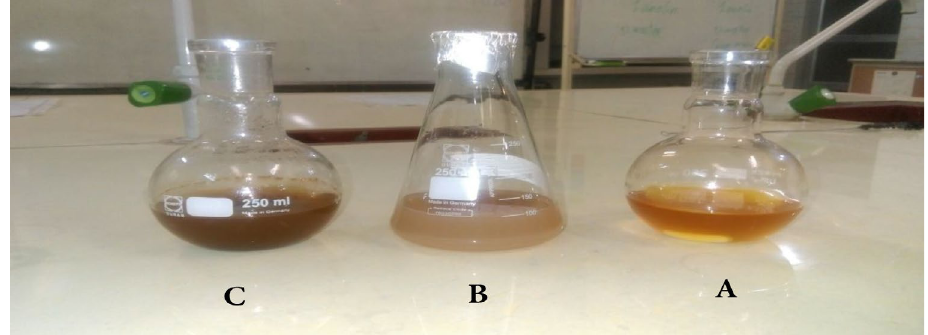
Fig. 2. (A) The crude extract of Avena sativa L. at 90°C for 24 h (B) with AgNo with AgNo at 90°C for 24h. The appearance of a brownish color confirmed the formation of silver 3